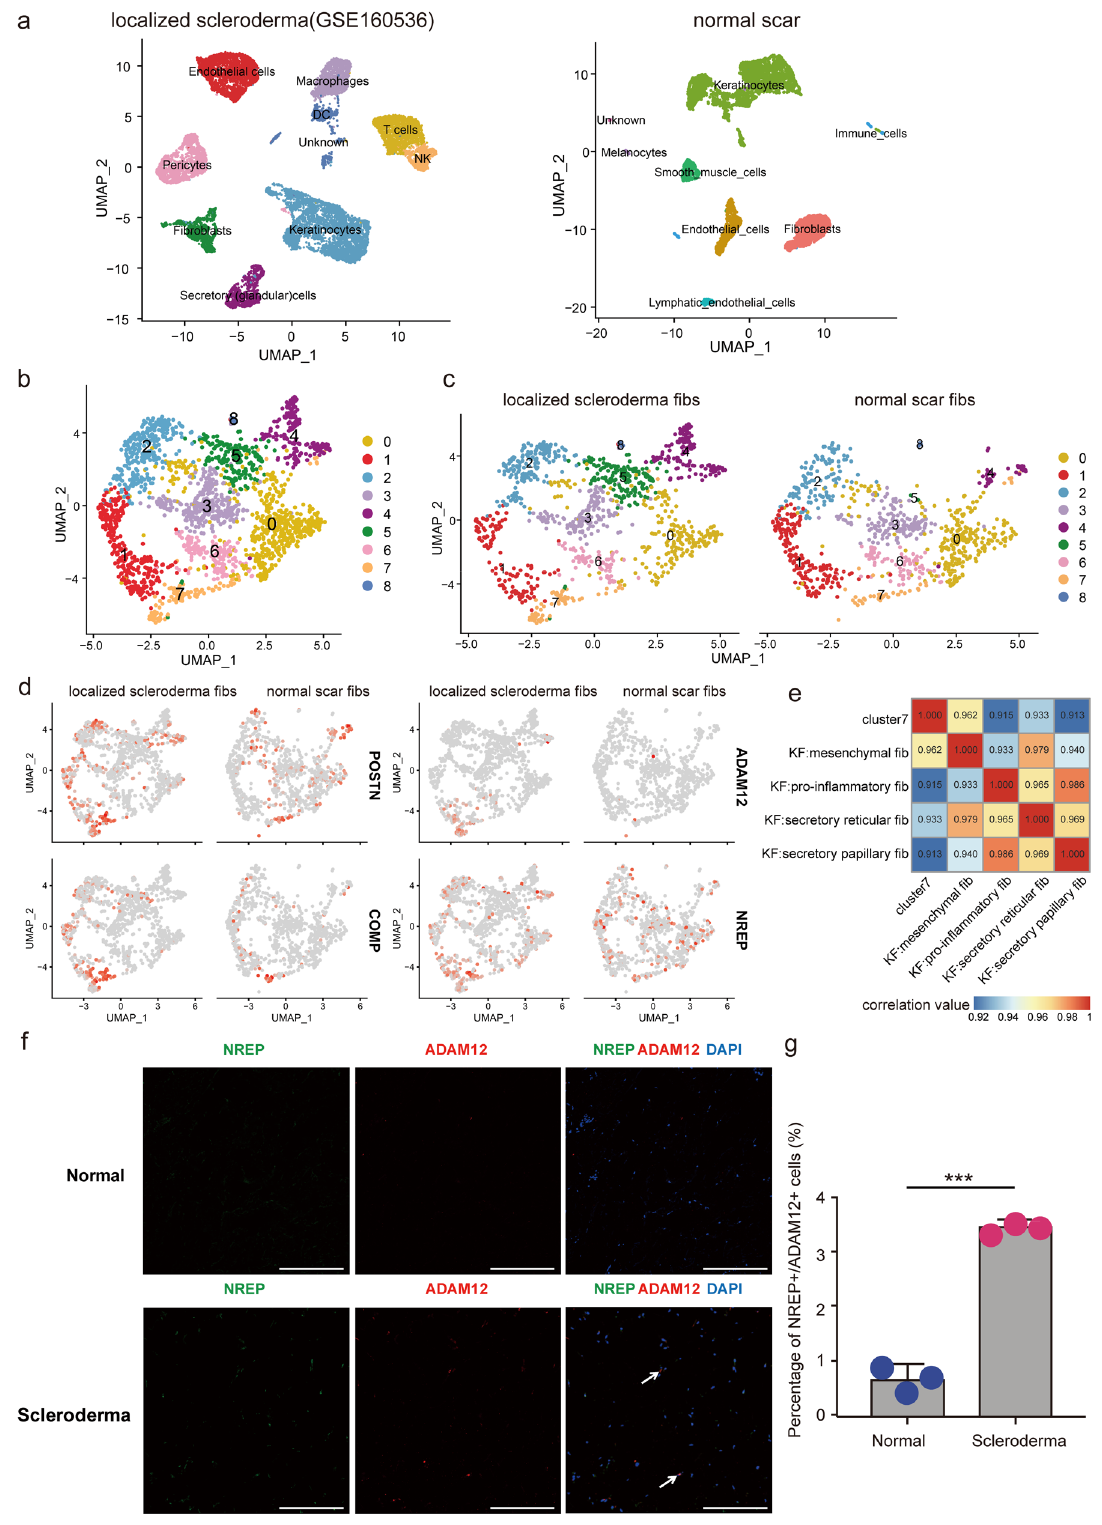
Fig. 7 Mesenchymal fi broblasts are increased in scleroderma. a UMAP visualization of dermal skin cell populations of patients with scleroderma (data from NCBI Gene Expression Omnibus (GSE160536)) in the left panel, and a normal scar (NS3) sample from our data is showed on the right. b Integration analysis of two sources of fi broblasts, one from scleroderma, and the other one from a normal scar. c Divided UMAP visualization of the integration results. d Feature plots of the expression distribution of mesenchymal signature genes in scleroderma and normal scar fi broblasts. e Correlation analysis of the average expression level of cluster 7 cells (scleroderma) and four types of fi broblasts from keloid samples. f Immuno fl uorescence staining of NREP and ADAM12 in normal and scleroderma tissues. Arrowheads indicate NREP + /ADAM12 + cells. Scale bar = 200 μ m. g Percentage of NREP + /ADAM12 + cells in normal and scleroderma tissues. Data are presented as mean values±SD ( n = 5 images examined over 3 independent experiments). Two-sided unpaired t -test, *** P =